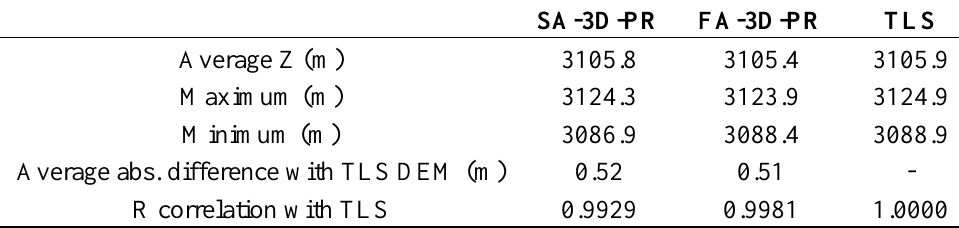
Table 4. Statistical description of every single Digital Elevation Model (DEM): Semi-Automatic 3D Photo-Reconstruction (SA-3D-PR) DEM, Fully-Automatic 3D Photo-Reconstruction (FA-3D-PR) DEM and Terrestrial Laser Scanner (TLS) DEM. Additionally, the average absolute difference with TLS DEM is